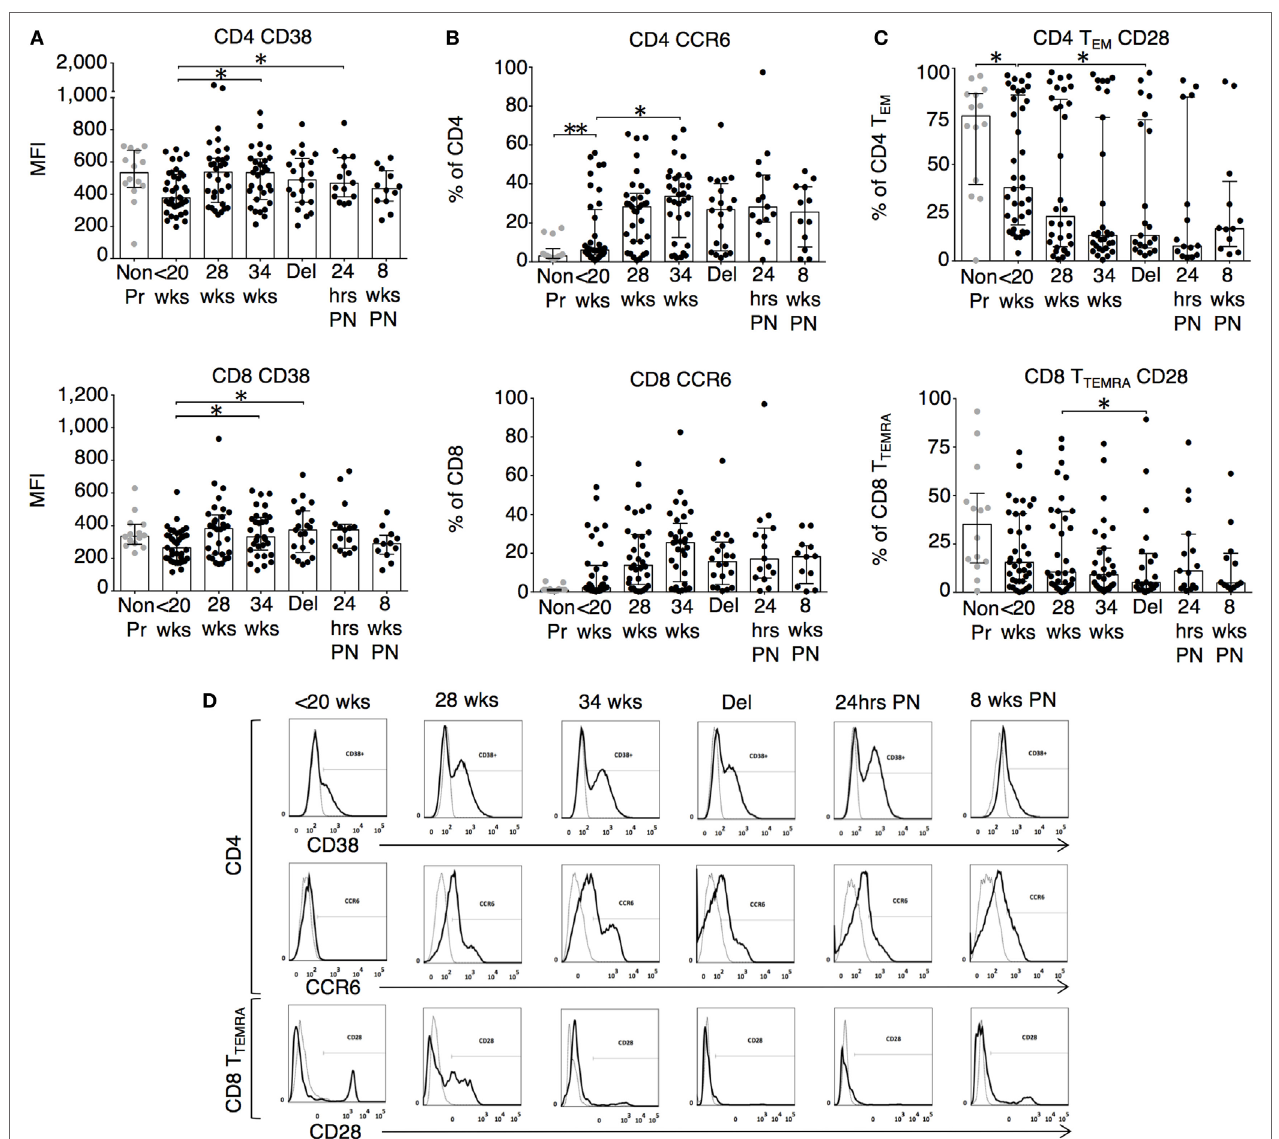
FigUre 2 | Leukocyte phenotype during pregnancy shows increased activation and migratory potential. (a) CD38 mean fluorescence intensity and the proportion of expression of (B) CCR6 on CD4 and CD8 T cells; (c) CD28 expression on CD4 T EM (CCR7 − CD45RA − ) and CD8 T TEMRA (CCR7 − CD45RA + ) T cell subtypes analyzed longitudinally with gestation and compared to controls. Gestation at sampling is indicated in pregnancy ( ⚫ ): < 20 + 0 weeks ( N = 42 ), 28 weeks ( N = 35 ), 34 weeks ( N = 33 ), at delivery ( N = 24 ), 24 h post-delivery ( N = 22 ), 6–8 weeks postnatal ( N = 13 ). Non-pregnant controls are depicted as ⚫ ( N = 14 ). P values are two tailed and significance is defined as * P < 0.05 and ** P < 0.01. Non-pregnant and baseline pregnant data analyzed by Mann–Whitney U test. Longitudinal data analyzed by generalized linear mixed effects model with gamma log-link and pairwise multiple comparisons of estimated marginal means with sequential Bonferroni correction. (D) Shows representative flow cytometry histograms across gestations with matched isotype controls for CD38 and CCR6 expression on CD4 T cells as well as CD28 expression on CD8 T TEMRA and HLA-DR expression on CD8 T